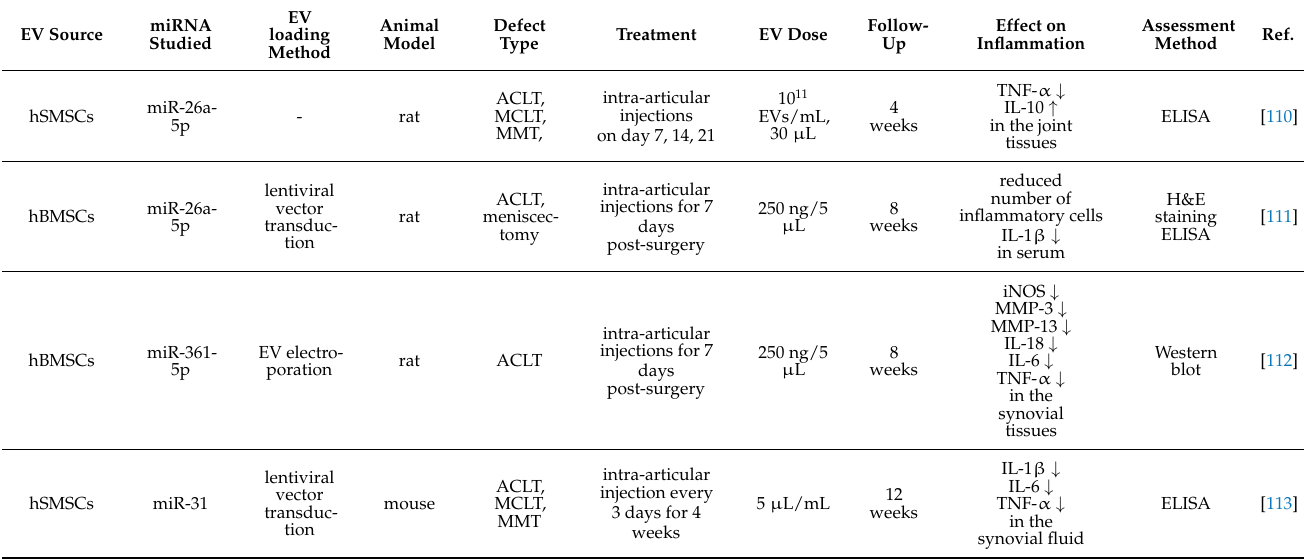
Table 2. Inflammation-targeting EVs for treating cartilage defects in